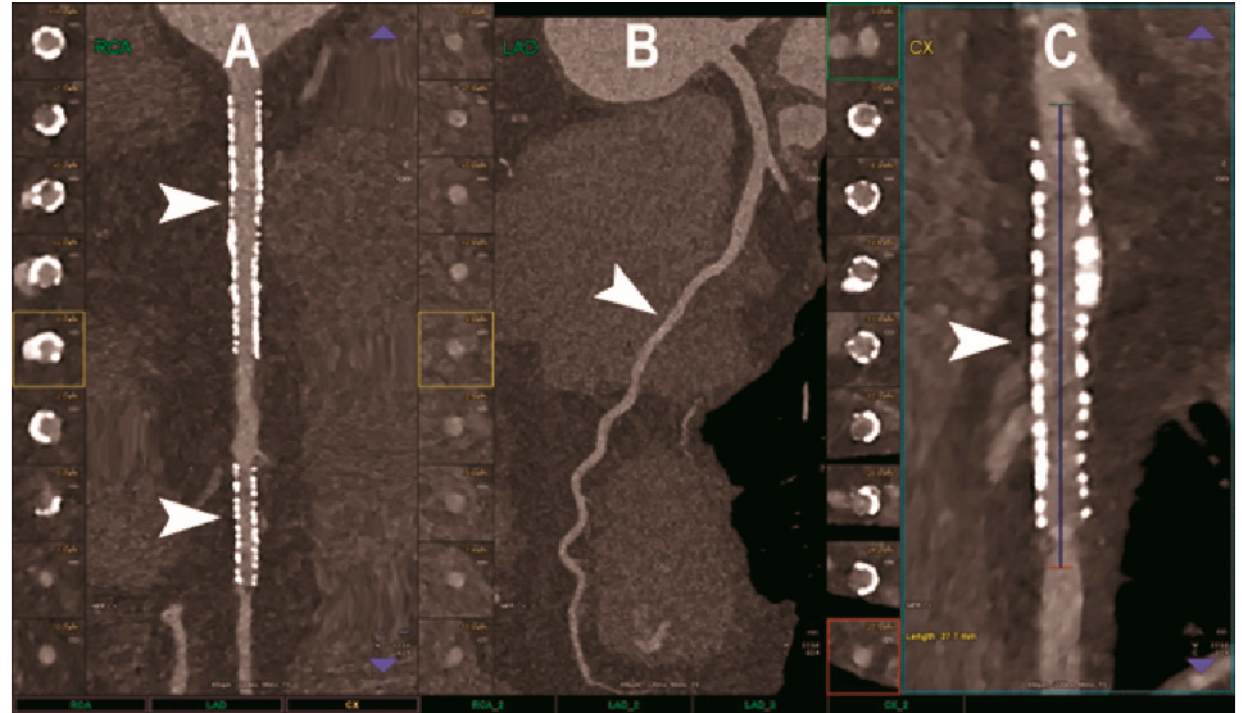
Figure 2. Cardiac CT using photon-counting computed tomography. The figure shows advanced multiplanar reconstructions of a coronary tree derived from a Photon-Counting CT (Scanner: NAEOTOM Alpha, Siemens) acquisition ( A – C ). In ( A ) we can see the right coronary artery with 2 stents (arrowheads), one proximal and one distal (much smaller), without any issue in the intrastent visualization of the arterial lumen. In ( B ), the left anterior descending coronary artery is depicted along its entire course (down to and beyond the left ventricular apex) with great detail and an evident deep intramyocardial course in the middle segment of the vessel (arrowhead). In ( C ), the left circumflex coronary artery also shows a stent with perfect intrastent visualization and patency (arrowhead).